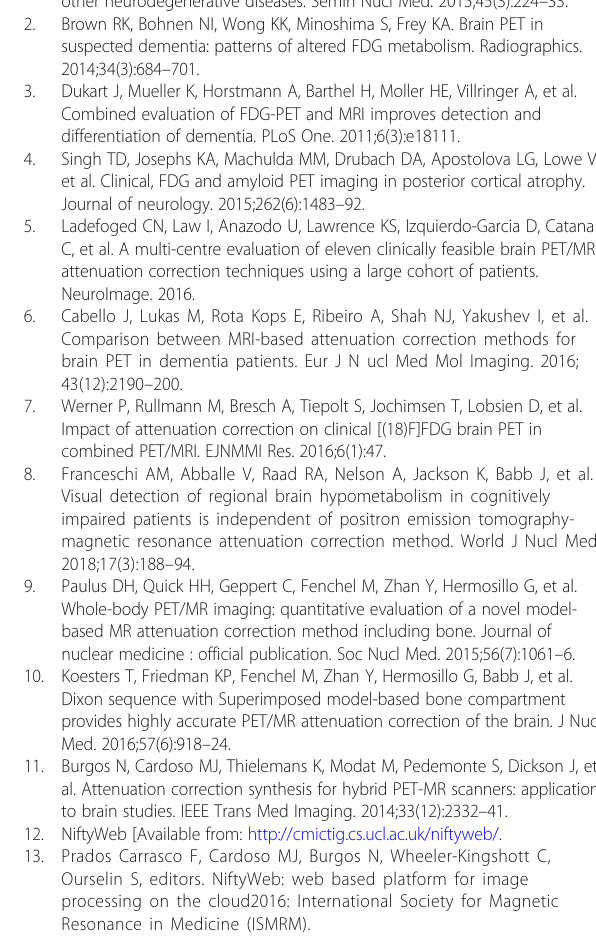
Additional file 1: Figure S1. Attenuation maps (top row) with corresponding PET images (bottom row) for patient number 3 with abnormal anatomy. (a) CT, (b) UCL, (c) DeepUTE, (d) Dixon Bone , (e)